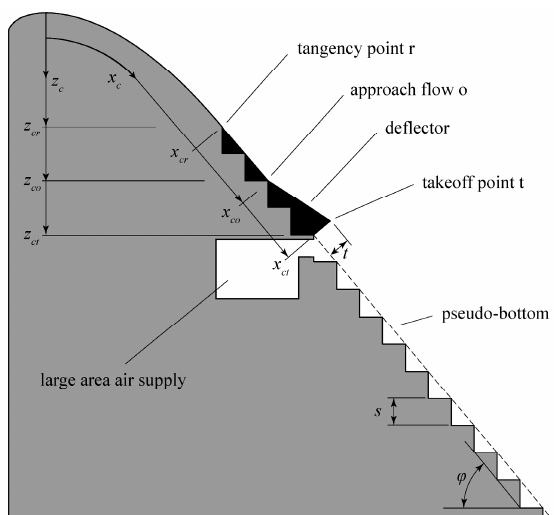
Figure 15. Definition scheme of the design example showing the upper part of the stepped chute in the vicinity of the aerator.